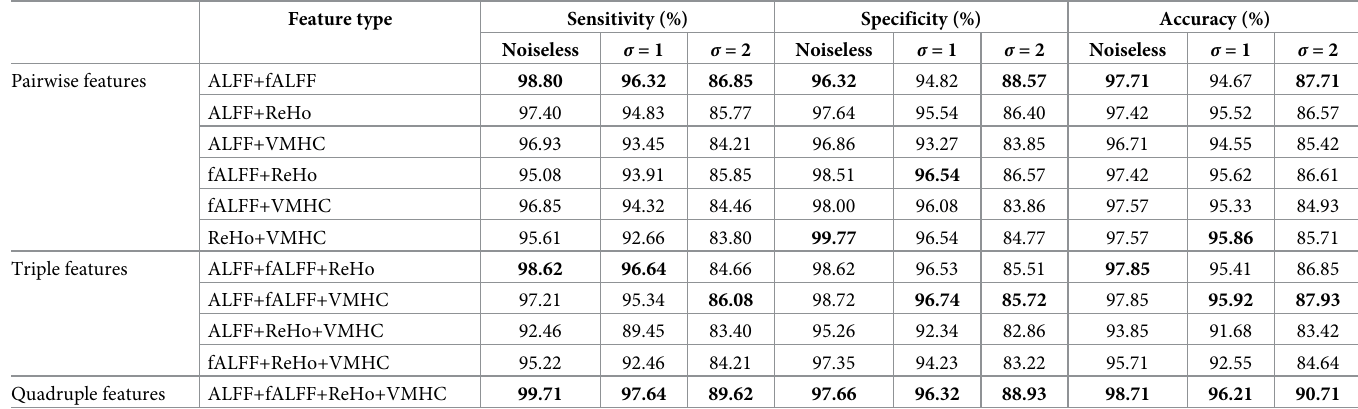
Table 9. Effects of Rician noise on schizophrenia detection performance with feature-level fusion of different pairwise, triple, and quadruple combinations of single feature types for fMRI data contaminated with Rician noise levels of σ = 1 and σ =